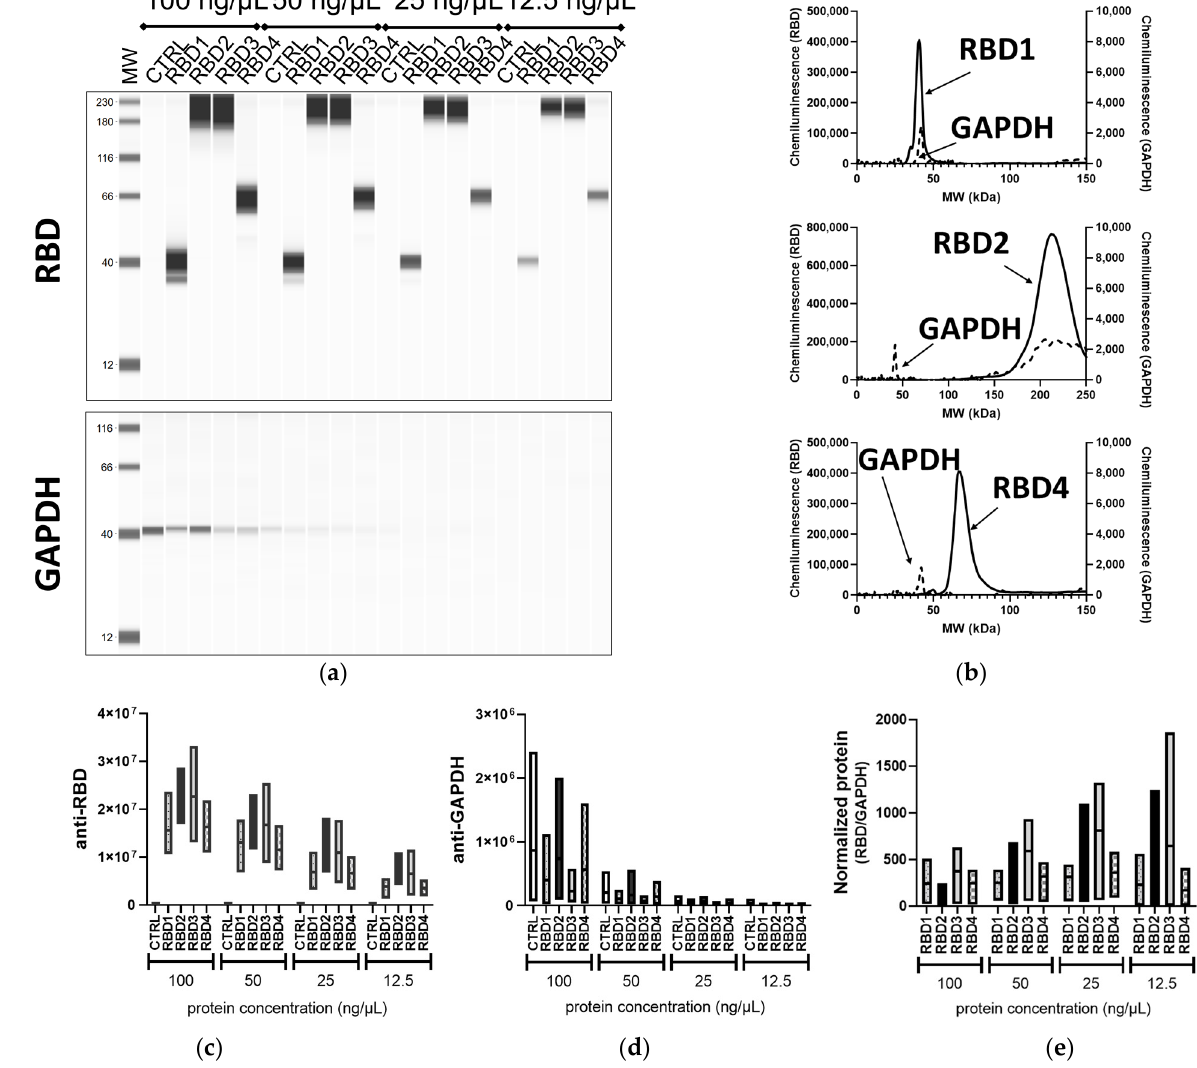
Figure 4. Assessment of transgene expression by JESS Simple Western™. Different concentrations (100, 50, 25, 12.5 ng/ µ L) of lysates from 293T cells transfected with vectors expressing RBD containing transgenes of different sizes (RBD1–4) or control transgene (CTRL) were processed in the fully automated JESS Simple Western™ device, probed with the SARS-CoV-2 RBD (1:50) and GAPDH (1:10) Abs. ( a ) Portrayal of a traditional blot-like image with a lane view of the samples. ( b ) An electropherogram representation of RBD1, RBD2, and RBD4 (50 ng/ µ L) samples for both the anti-RBD (solid line) and anti-GAPDH (dashed lines) analysis. Floating bar diagrams (minimum, maximum, and mean) of the peak areas corresponding to RBD ( c ) and GAPDH ( d ) protein from three independent experiments. ( e ) Floating bar diagram (minimum, maximum, and mean; n = 3) of the normalized RBD expression calculated from the peak areas of RBD and GAPDH